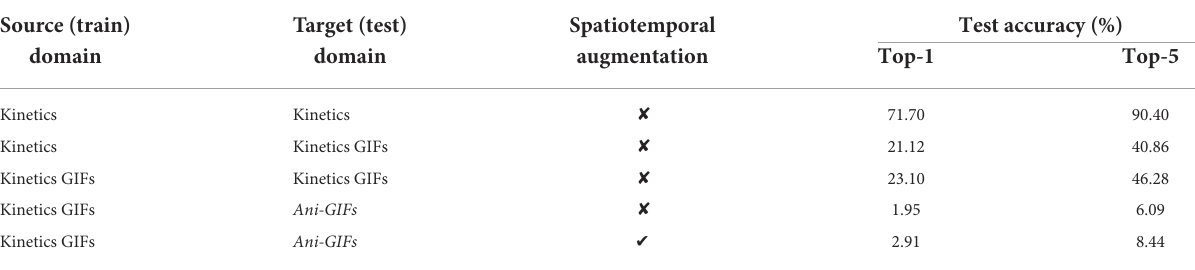
TABLE 2 Study 1 results. Top-1 and top-5 test accuracies of our baseline algorithm are given, from various training on different testing domains. Source (train)